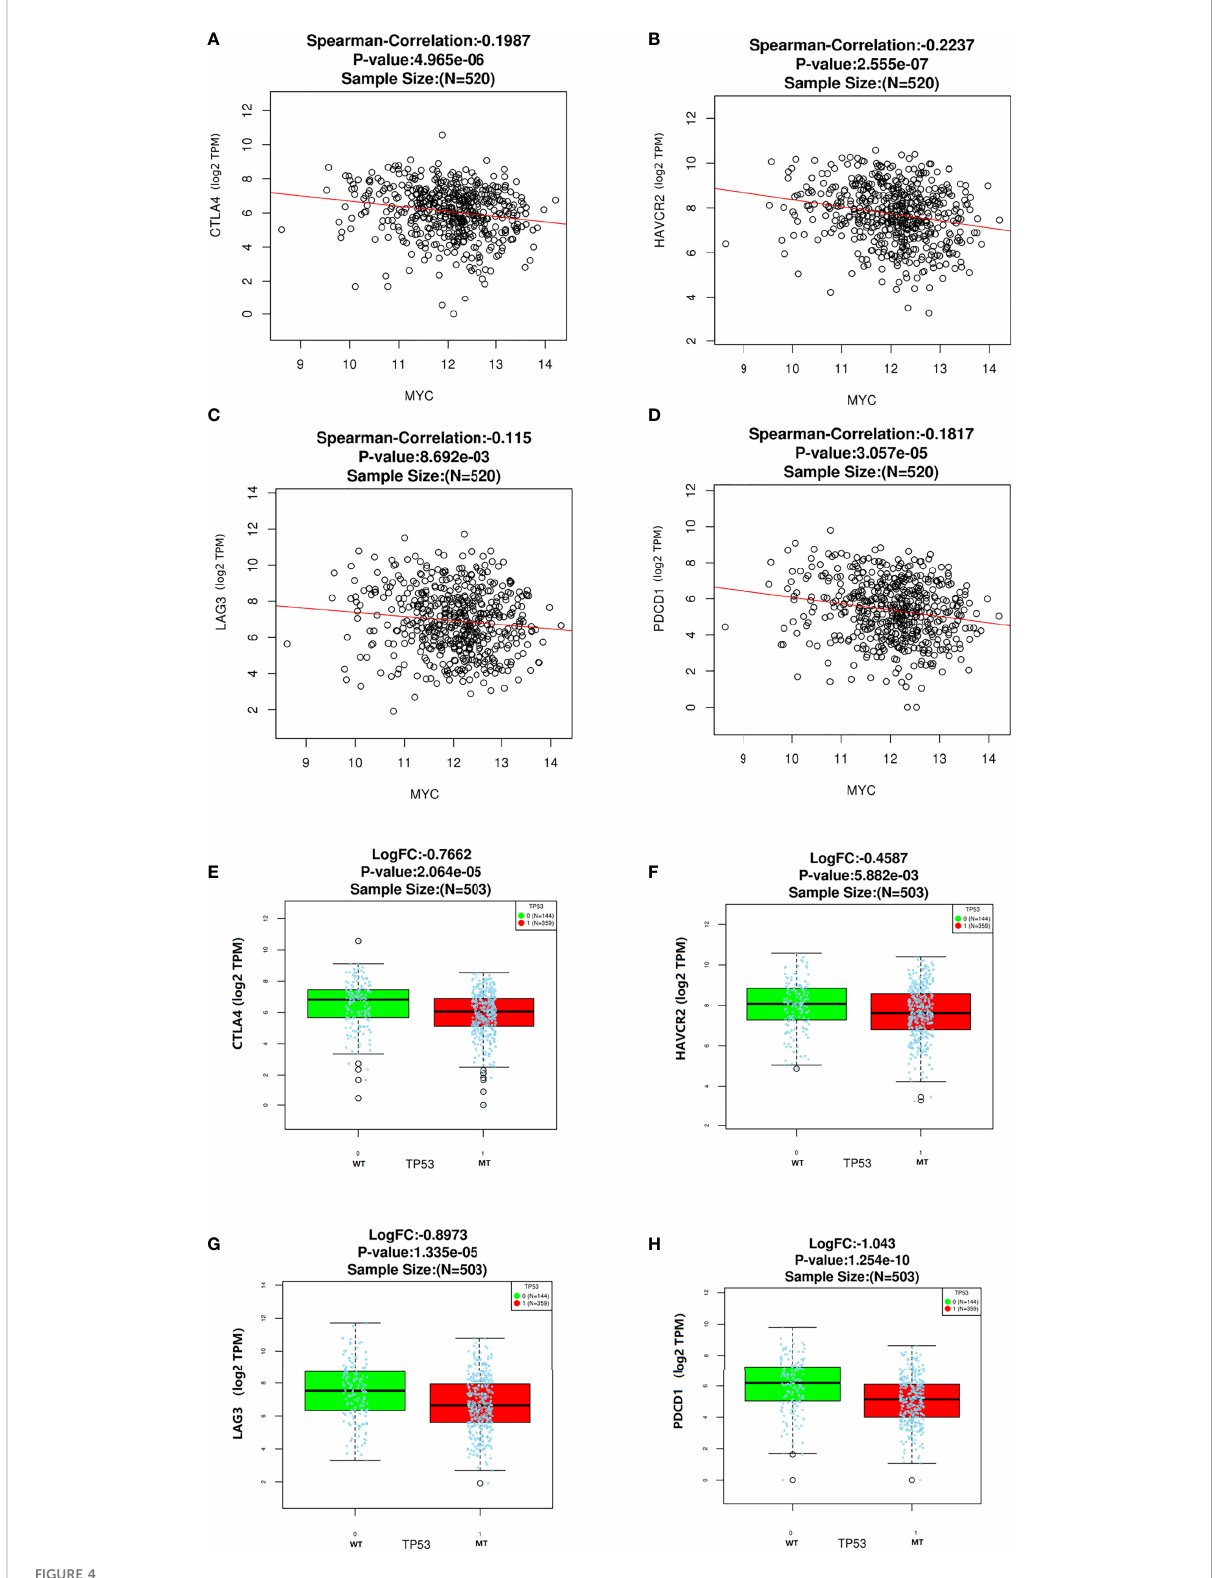
FIGURE 4 Correlation between c-Myc and immune checkpoints. (A) CTLA4. (B) HAVCR2. (C) LAG3. (D) Immune checkpoints expression based on TP 53 mutation status. (E) CTLA4. (F) HAVCR2. (G) LAG3. (H)